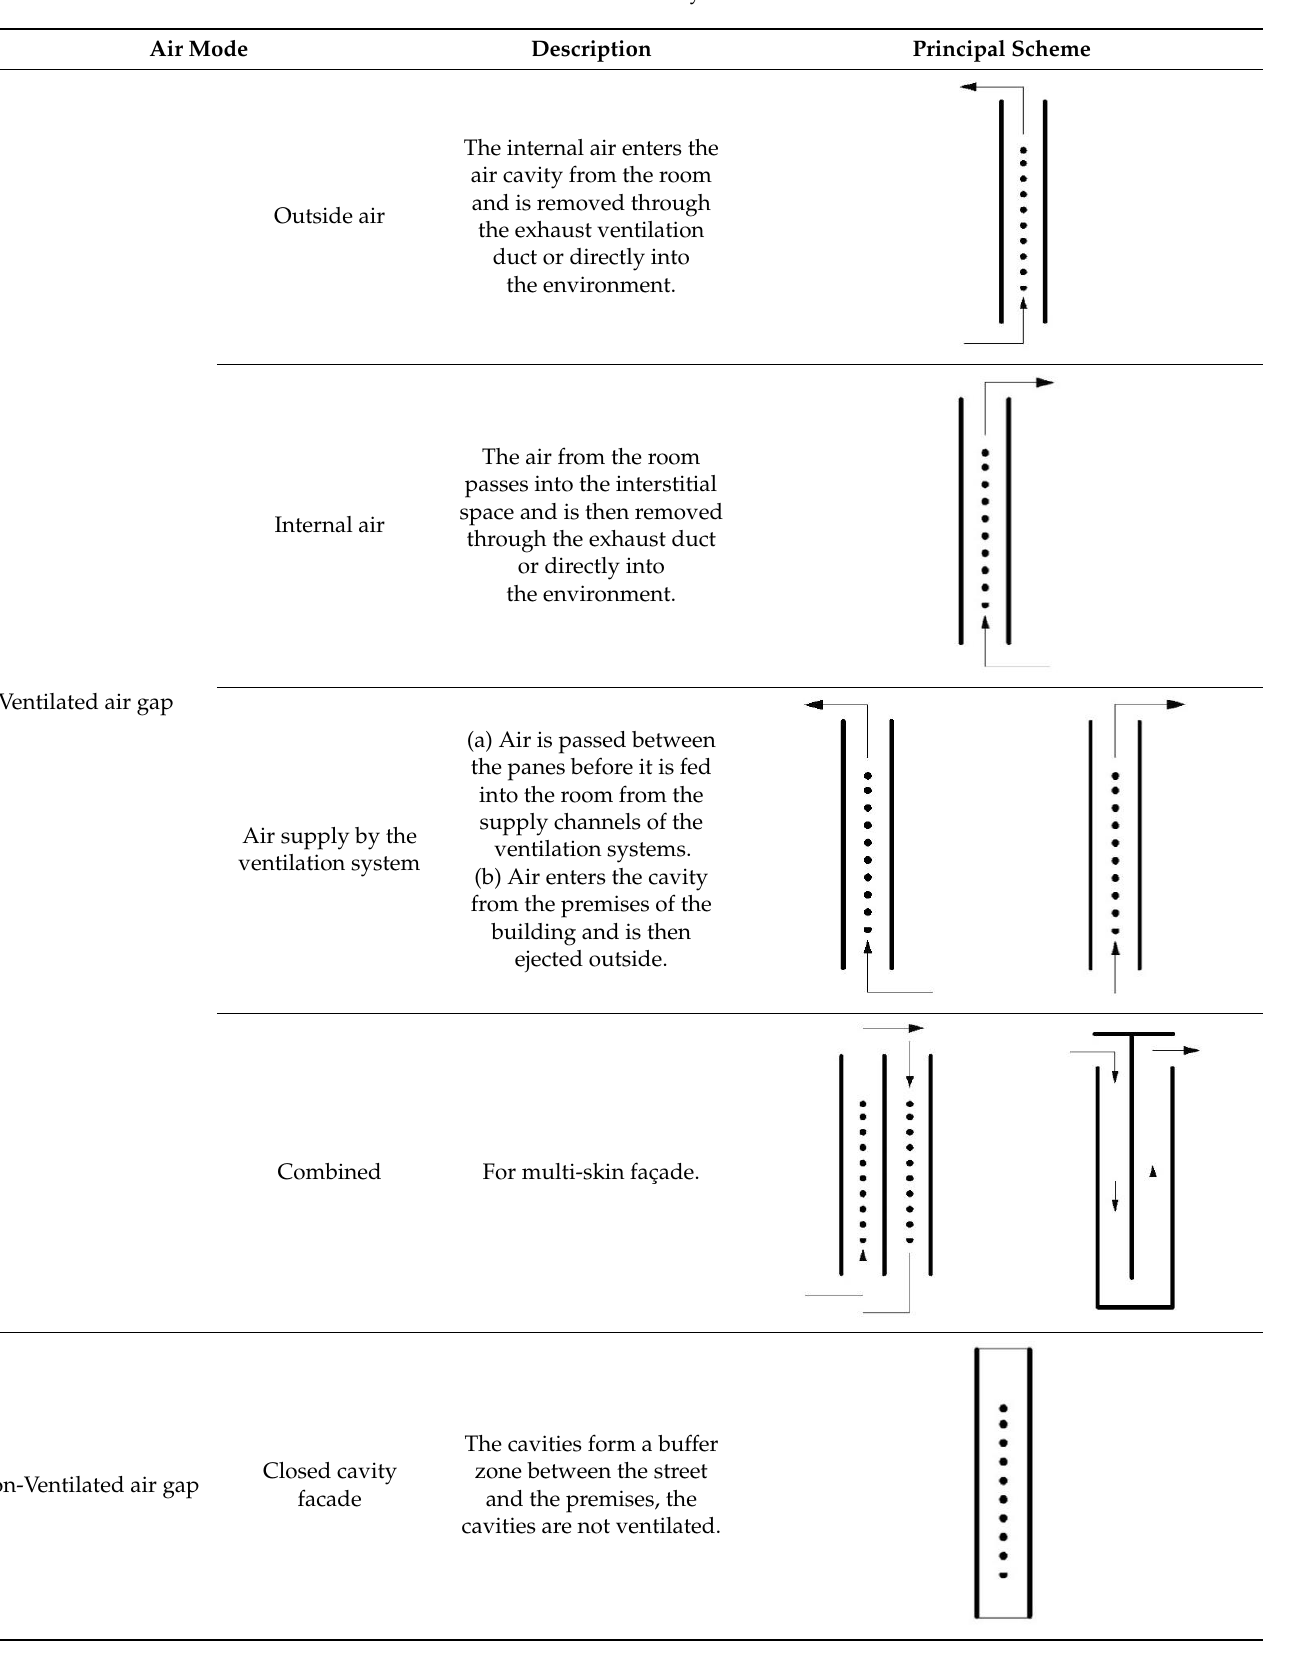
Table 2. Modes of ventilation of the air layers of the facade.